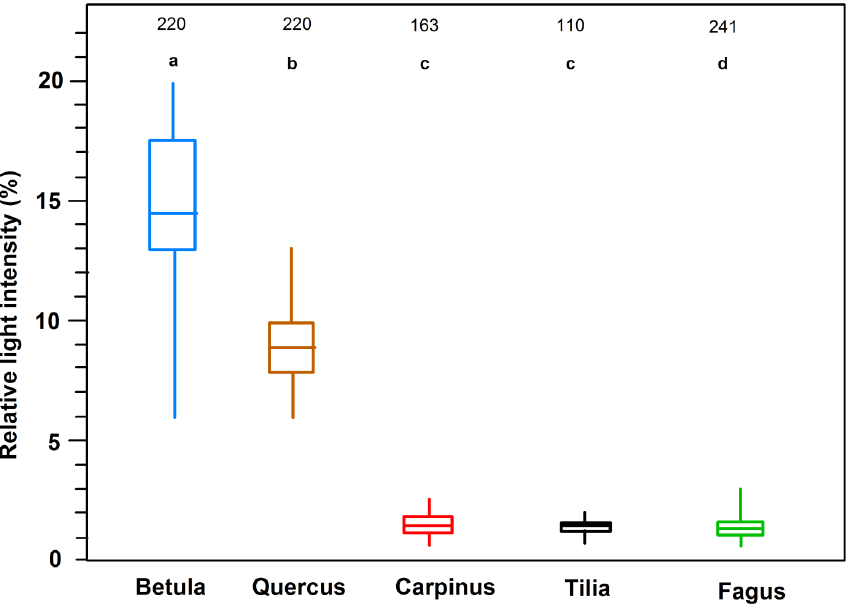
Figure 5. Relative PAR irradiance (in percent of incident radiation) on the forest floor in each two stands with closed canopy of the five tree species ( Tilia : only one stand). Paired measurements with two quantum sensors at 110–241 measurement points around noon (11 a.m.–2:00 p.m.) under overcast sky with one sensor placed in the open and the other moved on the forest floor. Box-whisker plots with median, 25- and 75-percentiles, and minima and maxima. Significantly different arithmetic means are indicated with different small letters.